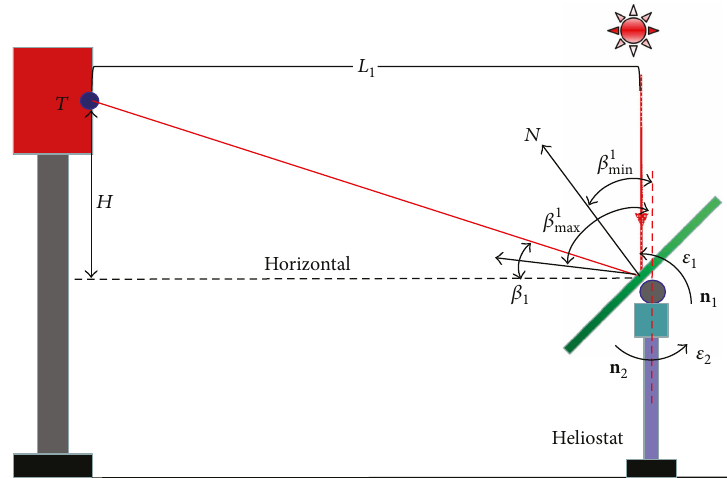
Figure 11: A schematic diagram of the elevation-azimuth double-axis tracking of a heliostat in a tower